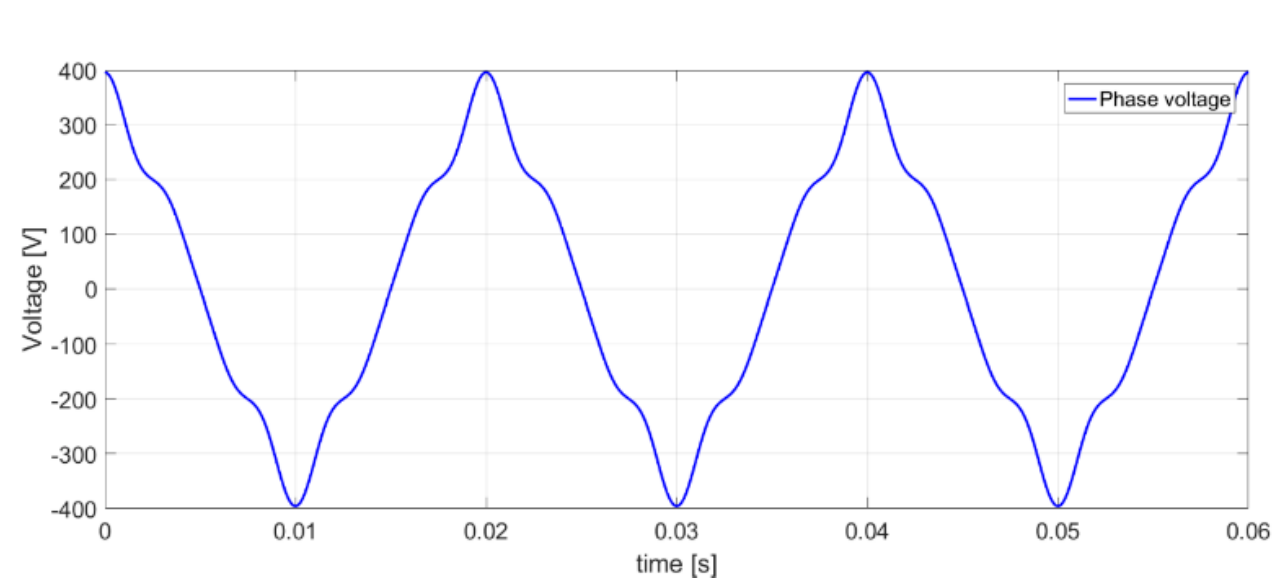
Figure 3. The waveform of phase voltage value at the terminals of load.